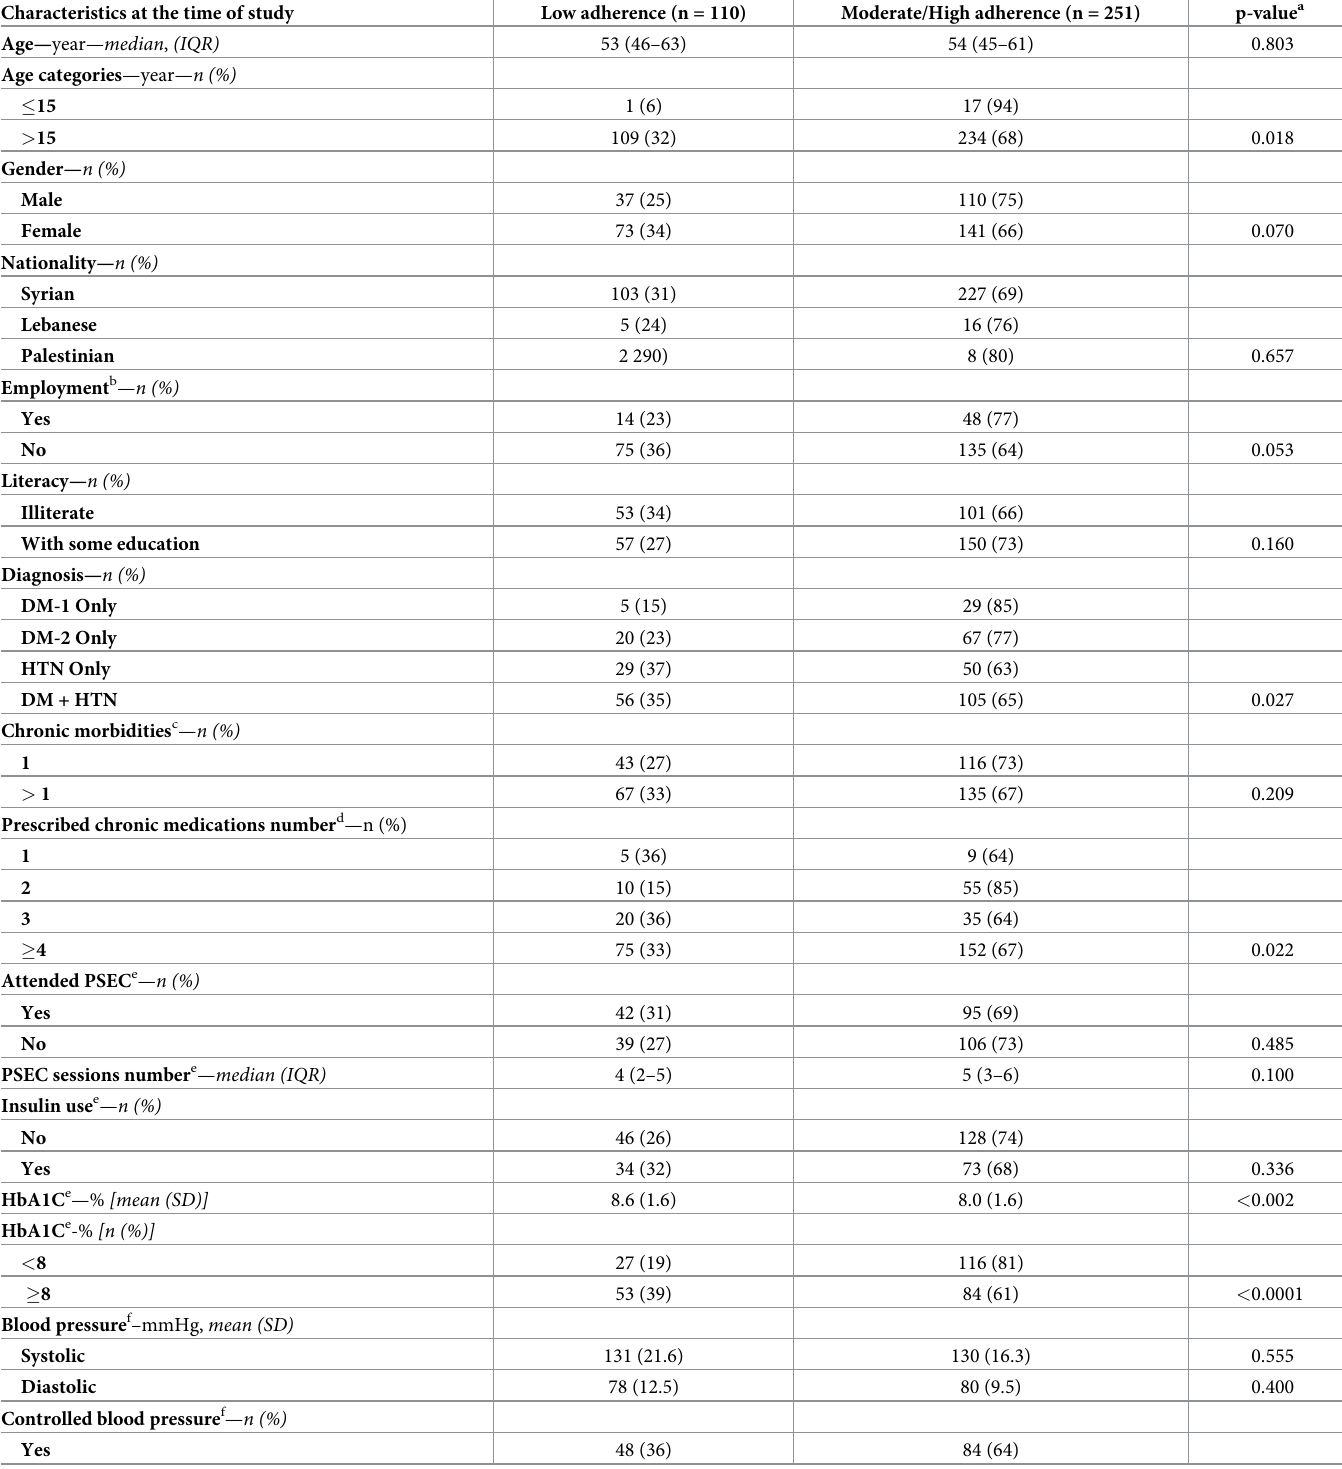
Table 3. Bivariate analyses among low adherence (MMAS-8 score < 6) and moderately/high adherence (MMAS-8 score � 6) for study participants, Shatila primary care clinic, Beirut, October 2018. Characteristics at the time of